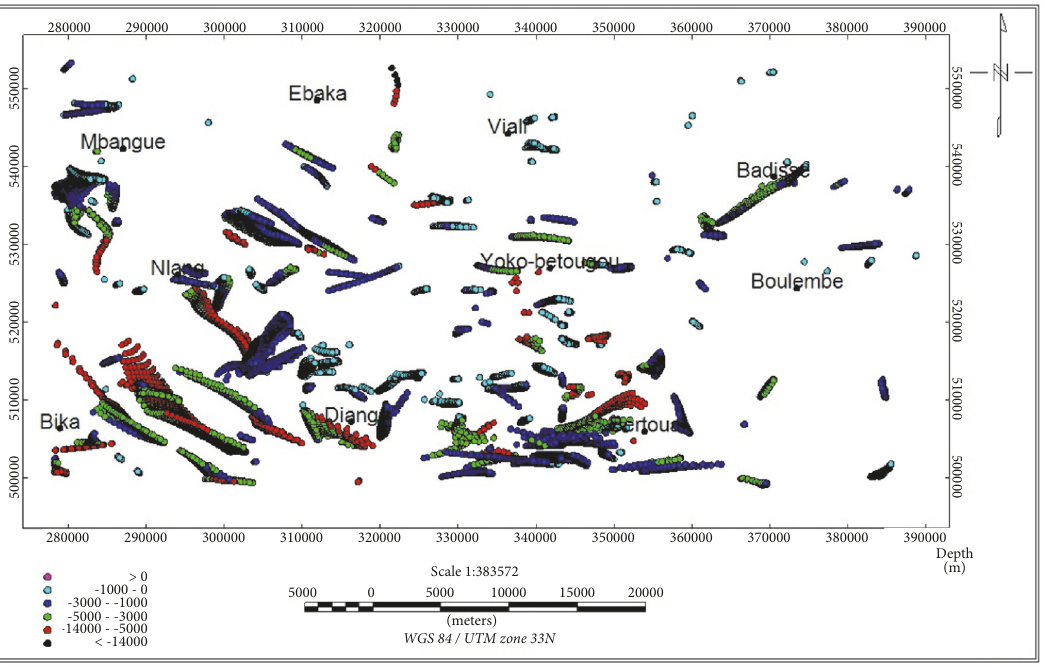
Figure 7: Euler solutions map.